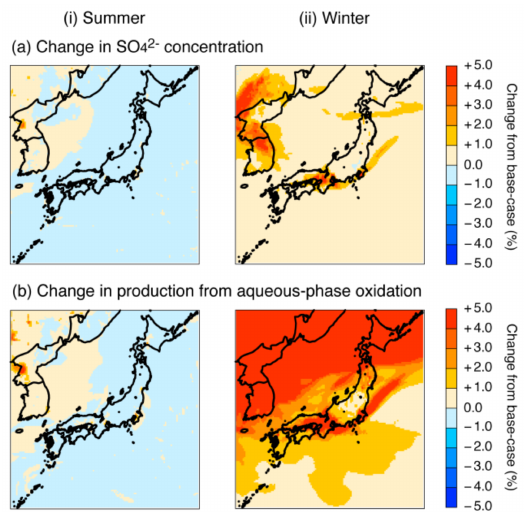
Figure 8. Changes in ( a ) SO 42 − concentration and ( b ) production from aqueous-phase oxidation averaged over ( i ) summer and ( ii ) winter. Model results from sensitivity simulation C are compared with the base-case simulation.